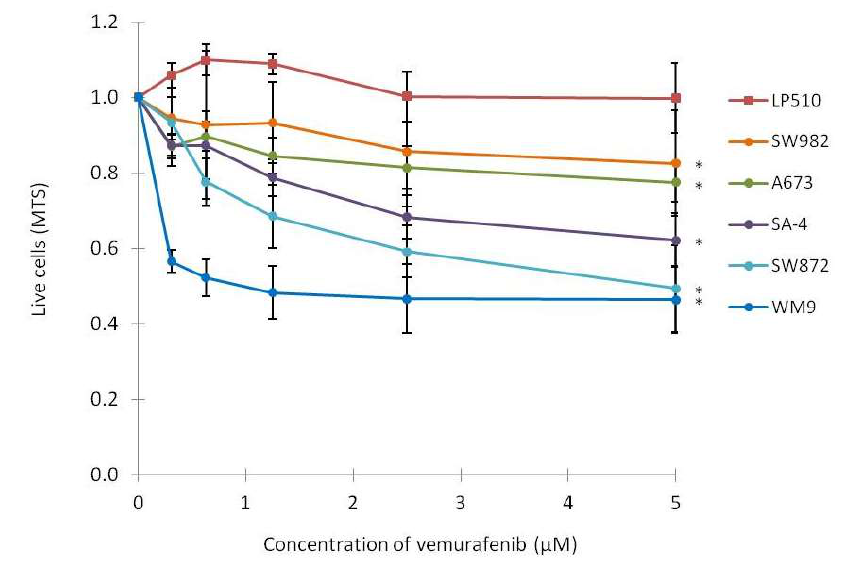
Figure 2. Effect on cell growth following vemurafenib treatment. Cell lines were treated with the indicated concentrations of vemurafenib or vehicle only, and MTS assay was performed 72 h (WM9, LPS510, SA-4 and A673) or 96 h (SW872 and SW982) after initiation of treatment. The absorbance at 450 nm was measured and normalized to vehicle-treated cells. Curves represent means of three biological experiments and error bars represent standard deviations (SD) ( n = 3). * indicates p < 0.05 at the highest dose.